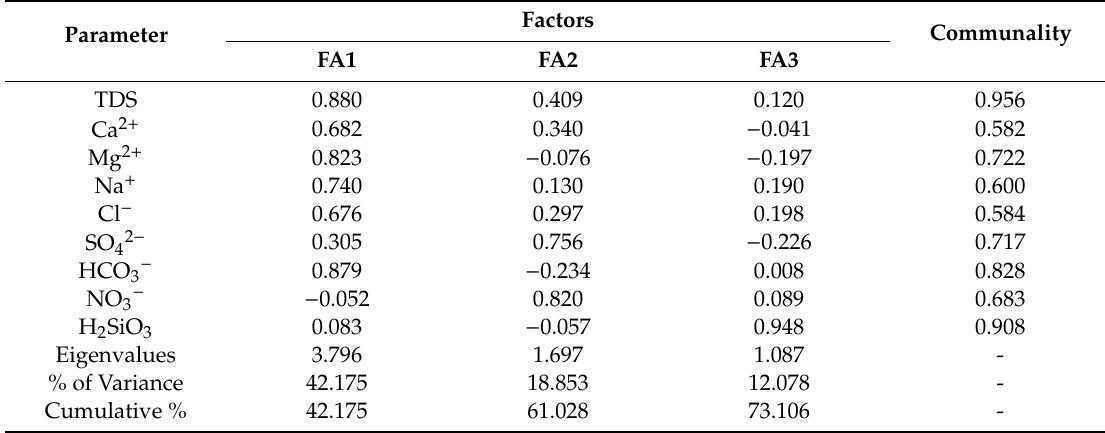
Table 4. Rotated component matrix for hydrogeochemical